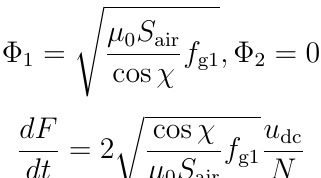
= 2 . 5 A and for the 0